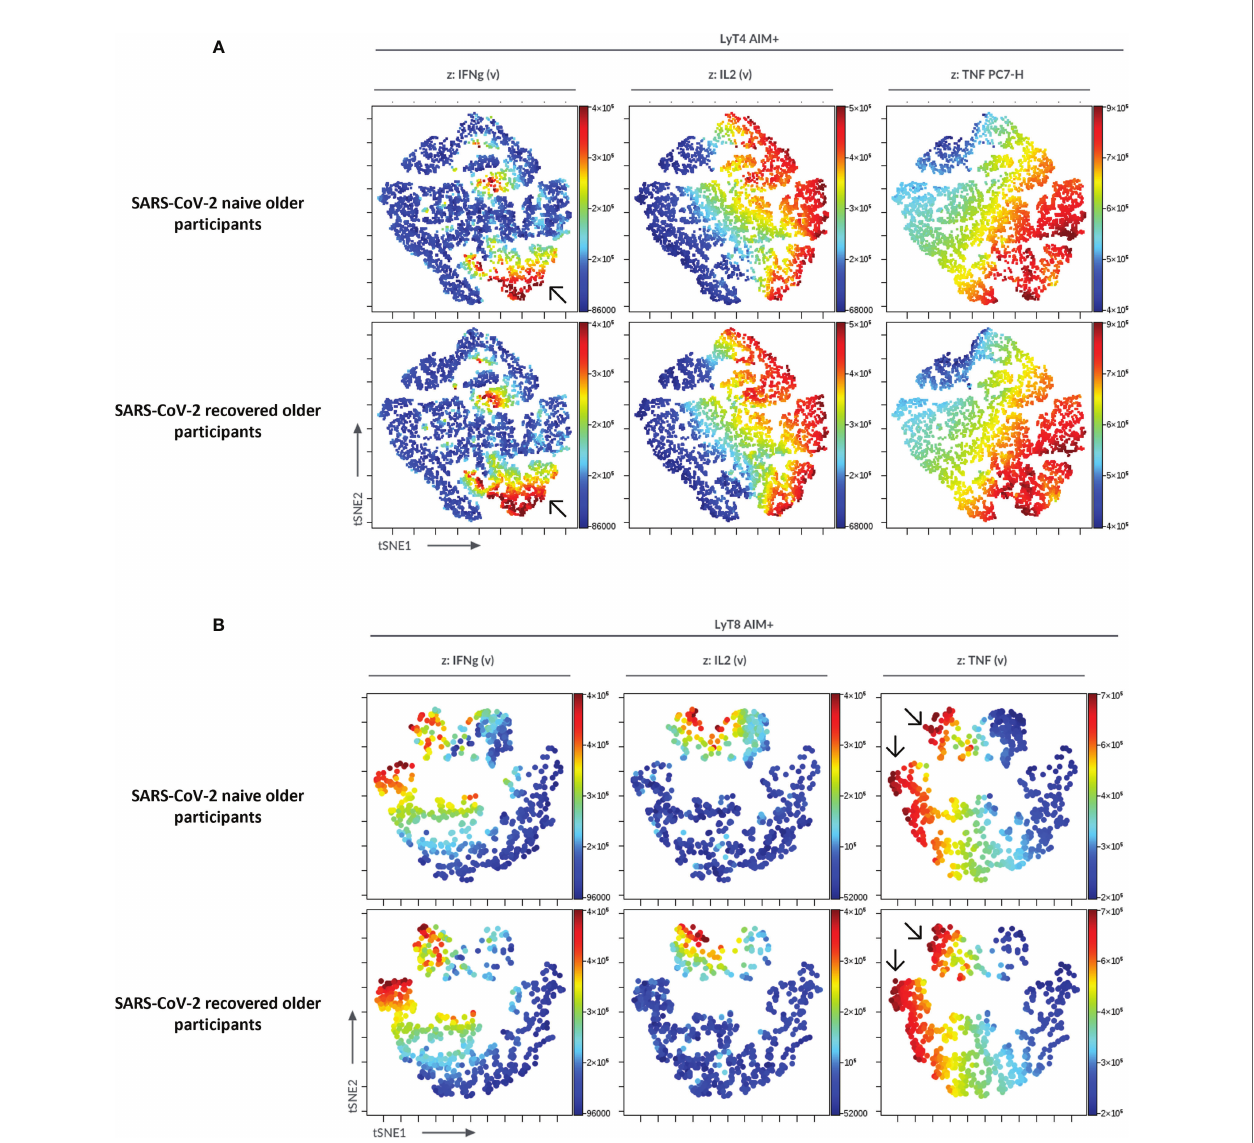
FIGURE 7 | Unsupervised analysis of CD4 + and CD8 + T-cell functionality in older participants using t-distributed stochastic neighbor embedding (t-SNE). AIM + CD4 + (A) and AIM + CD8 + (B) T cells from older participants were concatenated and subjected to unsupervised analysis using t-SNE; highlighted (z-dimension) are areas with IFN g , IL-2, or TNF a cell expression in COVID-19-naive and COVID-19-recovered older adults. To be noted, the higher frequency of IFN g + CD4 + T cells and of TNF a + CD8 + T cells in COVID-19-recovered older adults